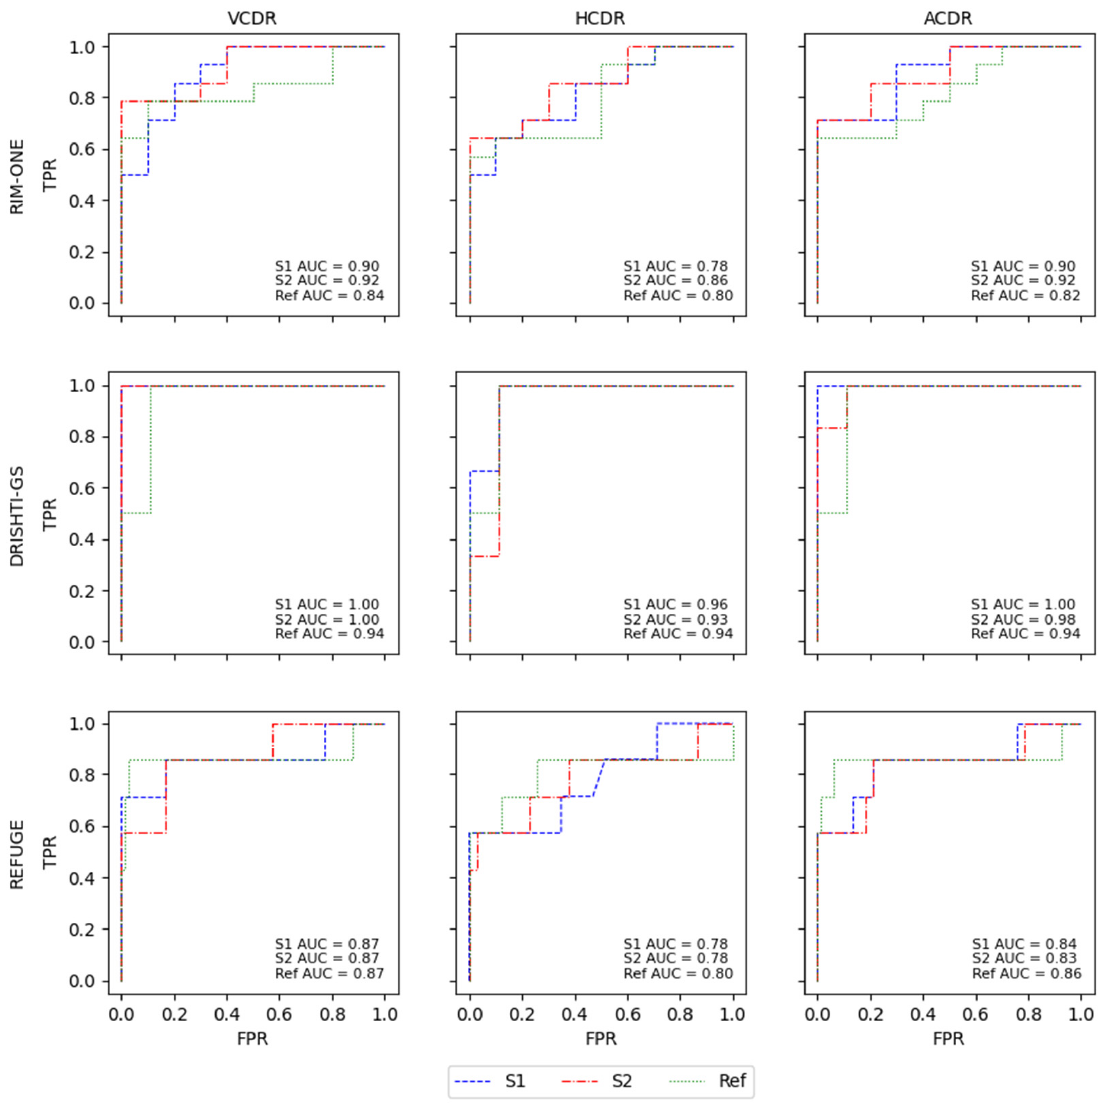
Figure 7. ROC curves for the glaucoma classification through CDR calculations for each database separately with the S1 and S2 models and the respective CDR calculations with the Ref masks.